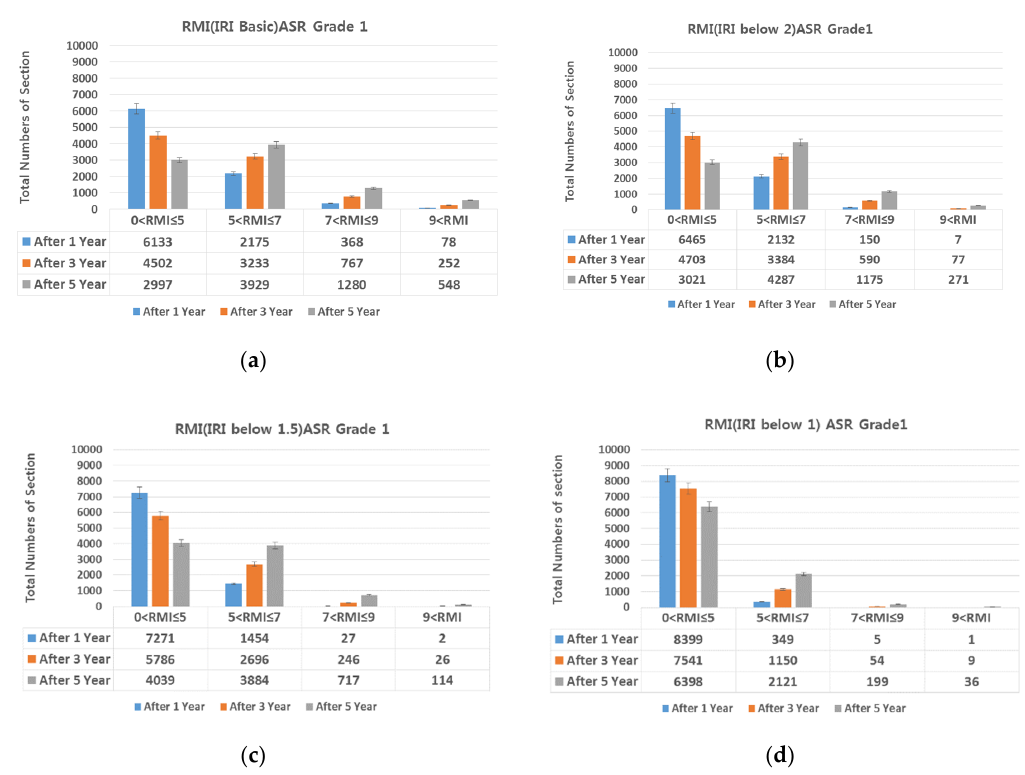
Figure 11. Change in number of sections per RMI with respect to IRI. ( a ) basic IRI and ASR grade 1; ( b ) IRI 2.0 and ASR grade 1; ( c ) IRI 1.5 and ASR grade 1; and ( d ) IRI 1 and ASR grade 1.